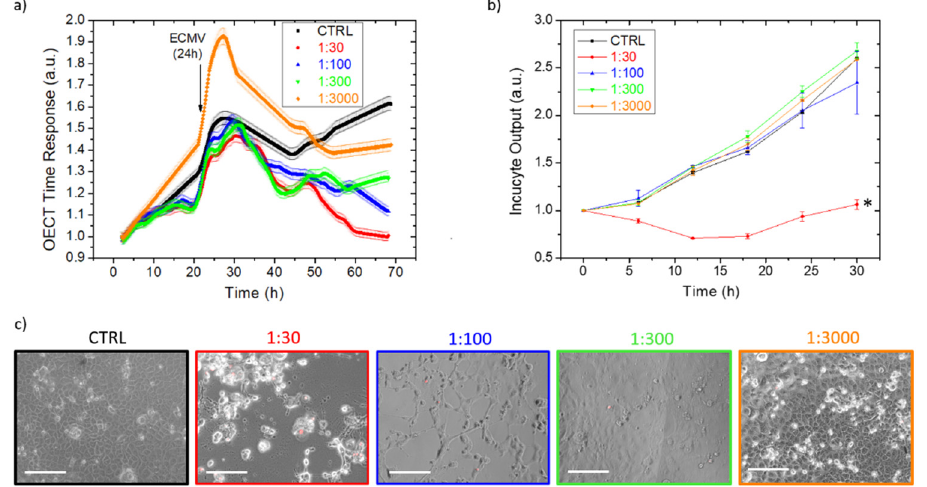
Figure 4. The OECT ( a ) and Incucyte ® ( b ) real-time monitoring of VERO E6 cells, infected with progressively diluted EMCV inocula, compared to a healthy cell growth, as the control. Each OECT time response point is the average of five consecutive measurements, having the standard deviation reported as the curve shadow. ( c ) The optical micrographs on the active area of the devices after 48 h of incubation, with different dilutions of EMCV and the control over a standard healthy growth, using a red staining dye for dead cells. White scale bars = 150 μ m. * p < 0.05 denotes a significant difference compared to the control.